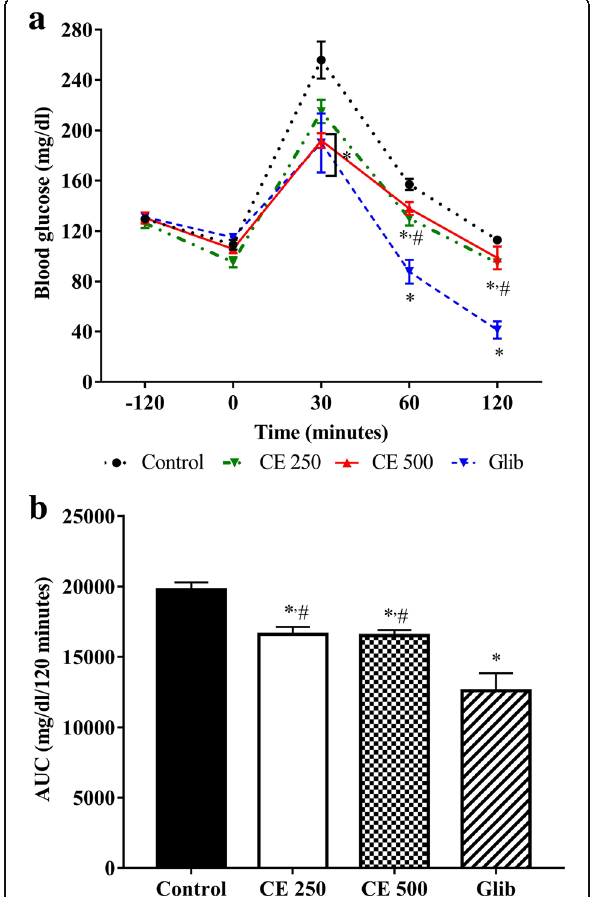
Fig. 2 Effect of C. cainito extract on OGTT in normal mice. Panel a is blood glucose level during oral glucose challenge whereas Panel b is the area under the curve (AUC) of the blood glucose level over time. * P < 0.05 compared with control mice; # P < 0.05 compared with glibenclamide treated mice by one-way ANOVA followed by Student-Newman-Keuls as post hoc test. The values are expressed as mean ± SEM, n = 6. Glib: glibenclamide; CE: C. cainito